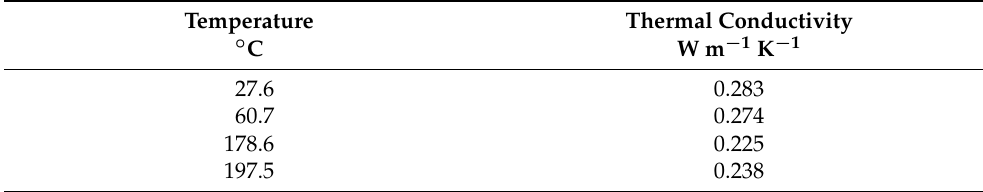
Finally, the thermal conductivity is given in Table A3. Table A3. Measured thermal conductivity of the